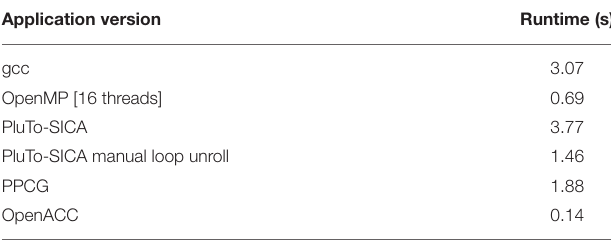
TABLE 1 | Runtimes of pattern